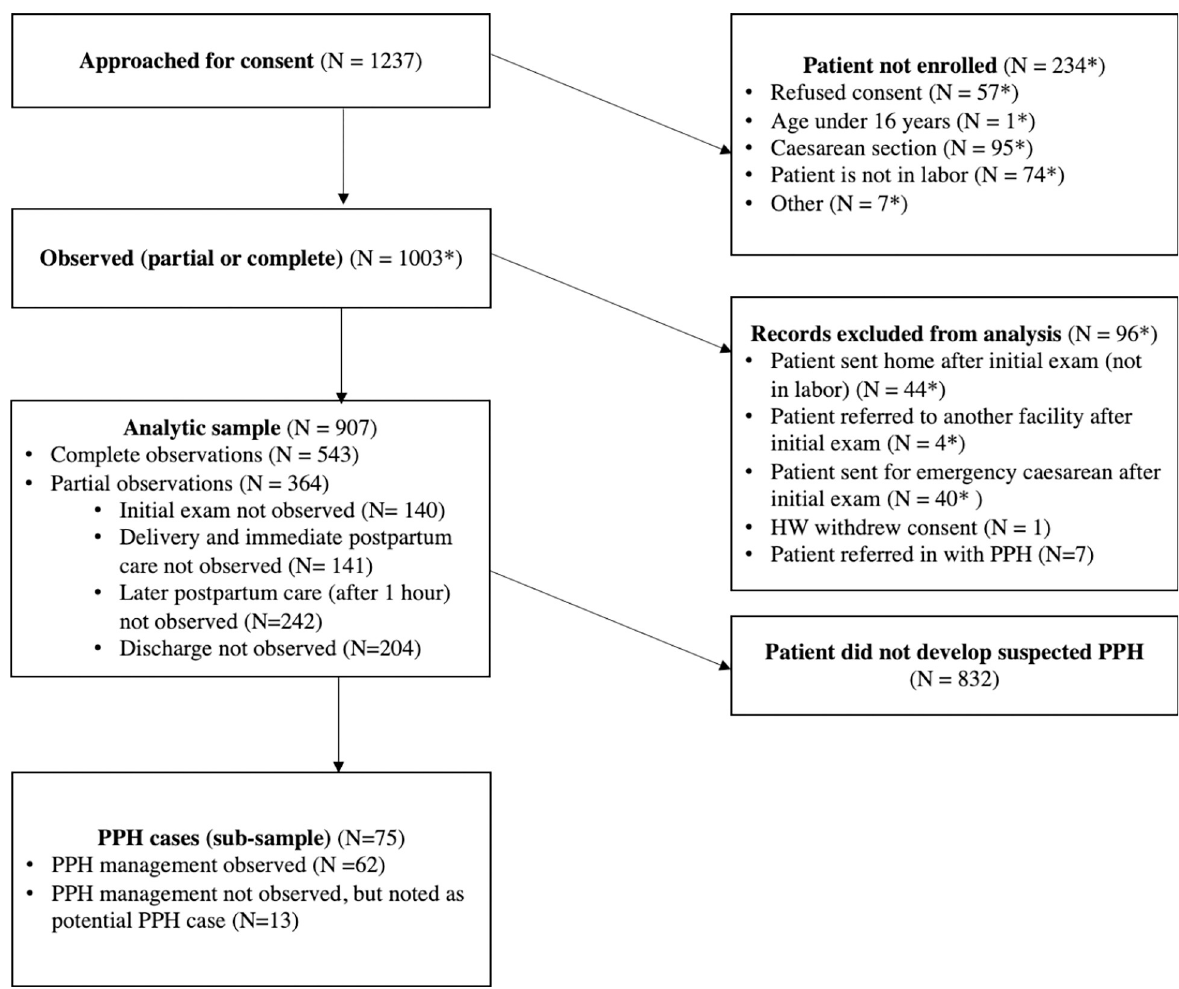
Fig 1. Sample flowchart. Notes: HW stands for Health Worker. PPH stands for postpartum hemorrhage. � Indicates that this number is incomplete because unobserved cases were not tracked in one of the three study hospitals.